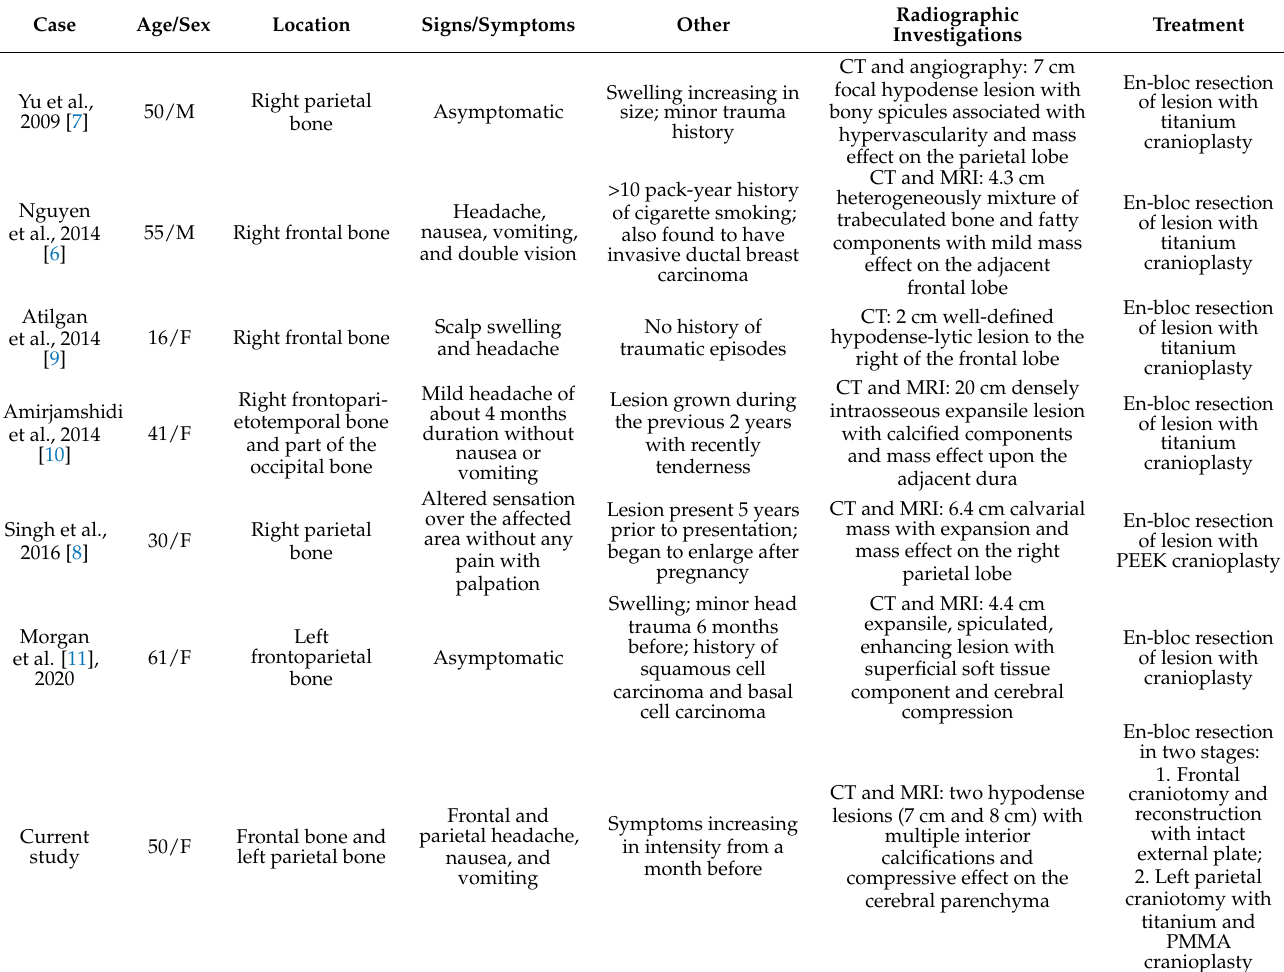
Table 1. Summary of cases of intraosseous angiolipoma of the